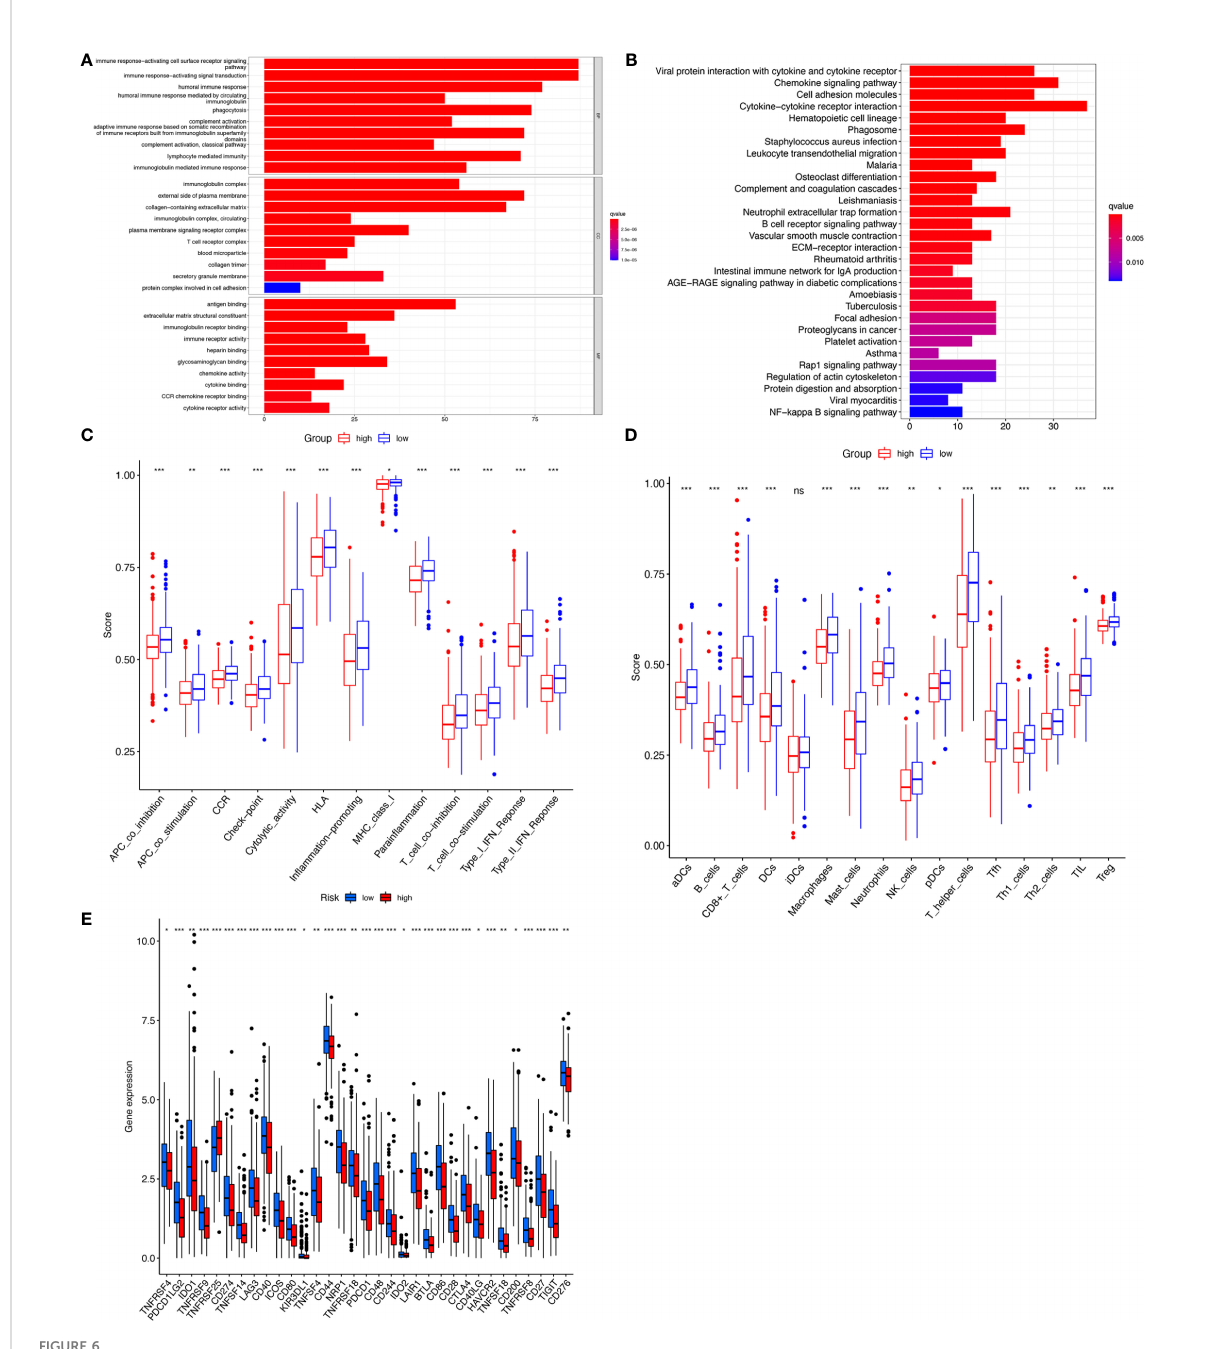
FIGURE 6 Immunoassay showed that the ten cuproptosis – related lncRNAs were closely related to the immune system. GO and KEGG enrichment analysis of the different expressed genes between two risk groups (A, B) . The ssGSEA scores of 13 immune-related functions (C) and 16 immune cells (D) between different risk groups are displayed in boxplots. Comparison of immune checkpoints between two risk groups (E) . nsP >= 0.05, *P < 0.05, **P < 0.01, ***P <